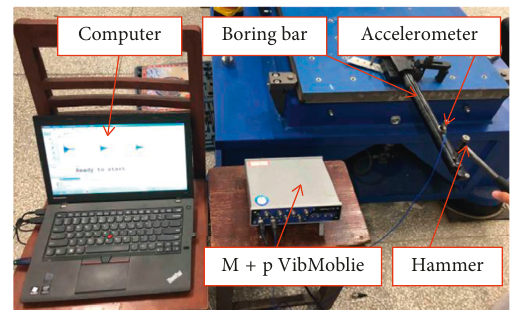
Figure 5: Impact test of the boring